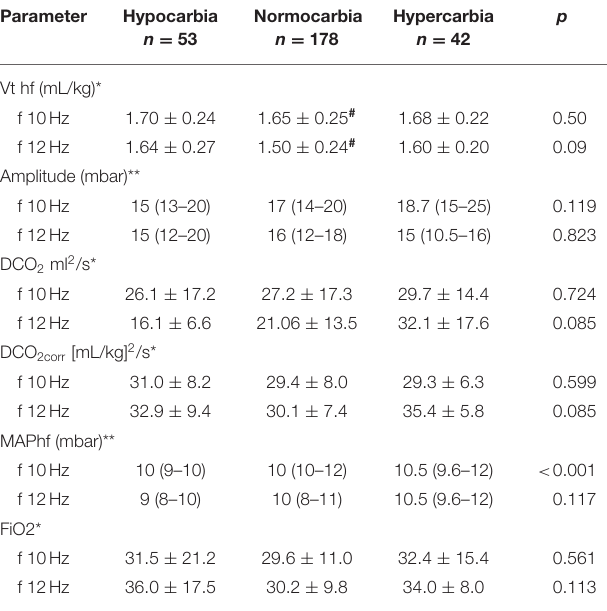
TABLE 2 | Ventilatory parameters corresponding to three pCO2 categories*. p Parameter Hypocarbia Normocarbia Hypercarbia n = 53 n = 178 n = 42